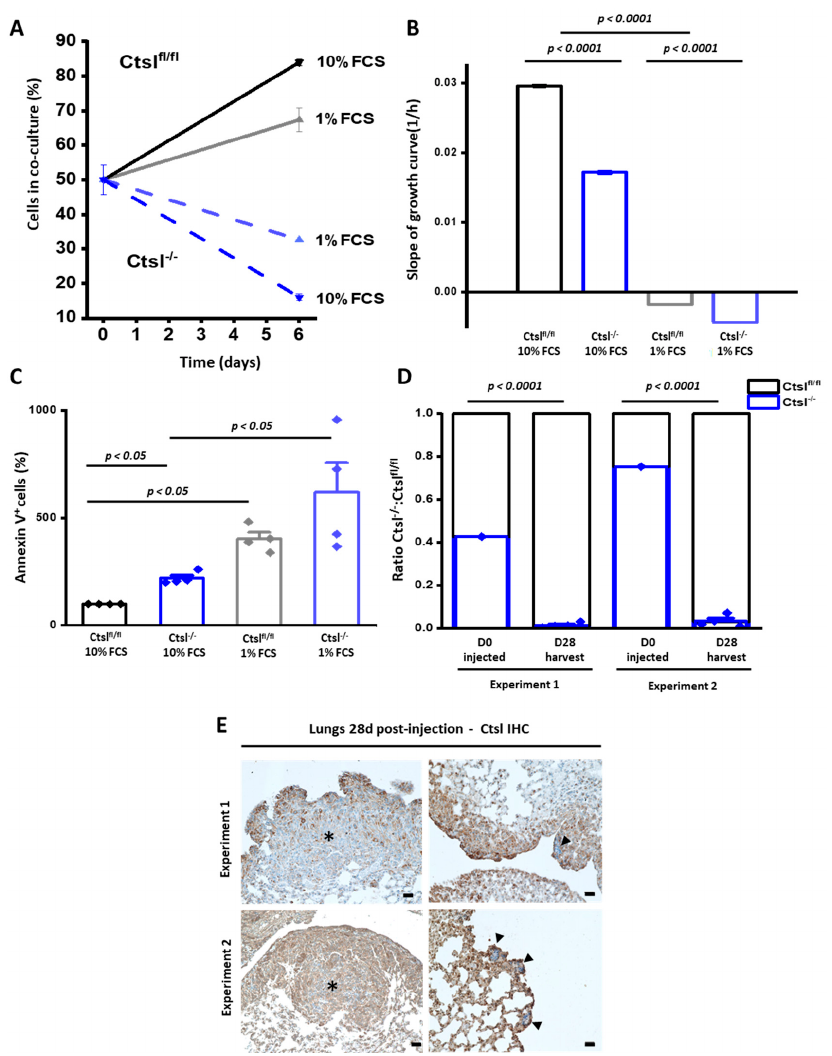
Figure 5. Ctsl − / − cells display defective proliferation and enhanced cell death. ( A ) Ctsl fl / fl cells outgrow Ctsl − / − cells after 6 days of mixed culturing. DNA copy numbers of Ctsl and CD79b , used as housekeeping genes, were quantified by droplet digital PCR. ( B ) Real-time proliferation analysis by measuring the impedance changes with an x-CELLigence system during 72 h. Negative slopes correlate to detachment of the cells from the plate ( n = 7) ( p < 0.0001, one-way ANOVA, Tukey post-hoc test); mean ± S.E.M. ( C ) Annexin V + cells analyzed by flow cytometry at standard culture conditions (10% fetal calf serum (FCS)) and serum reduction (1% FCS) (one-way ANOVA, Tukey post-hoc test; n = 4 independent experiments); mean ± S.E.M. ( D ) Experimental metastasis assay using two mice groups injected with Ctsl fl / fl and Ctsl − / − cell-co-cultures show a significant di ff erence in the capability of both cells in establishing metastasis in lungs. A first mixture containing around 45% (42.6%) Ctsl − / − and 55% Ctsl fl / fl cells was injected into immunodeficient mice by tail vein injection (Experiment 1). Quantification was performed after 28 days post-injection by droplet digital PCR in mashed lung tissue by analyzing the ratio of Cre recombinase and PyMT to distinguish tumor cells. Minute amounts of Cre genomic DNA, representing Ctsl − / − cells, could be found in the lungs of the injected mice (0.0136%). Similar observations (0.032% of Ctsl − / − cells) were achieved by repeating the procedure with a higher concentration of Ctsl − / − cells (75% to 25% Ctsl fl / fl ) (Experiment 2) ( n = 4 per experiment) ( p < 0.0001, one sample t -test); mean ± S.E.M. ( E ) Exemplary images of IHC for Ctsl in experimental metastasis assay lung slides. Both experiments resulted in large metastasis composed mainly of Ctsl fl / fl cells, marked with a star (*). Ctsl − / − cells form isolated micro metastasis, as indicated by arrowheads (Scale bar: 100 µ